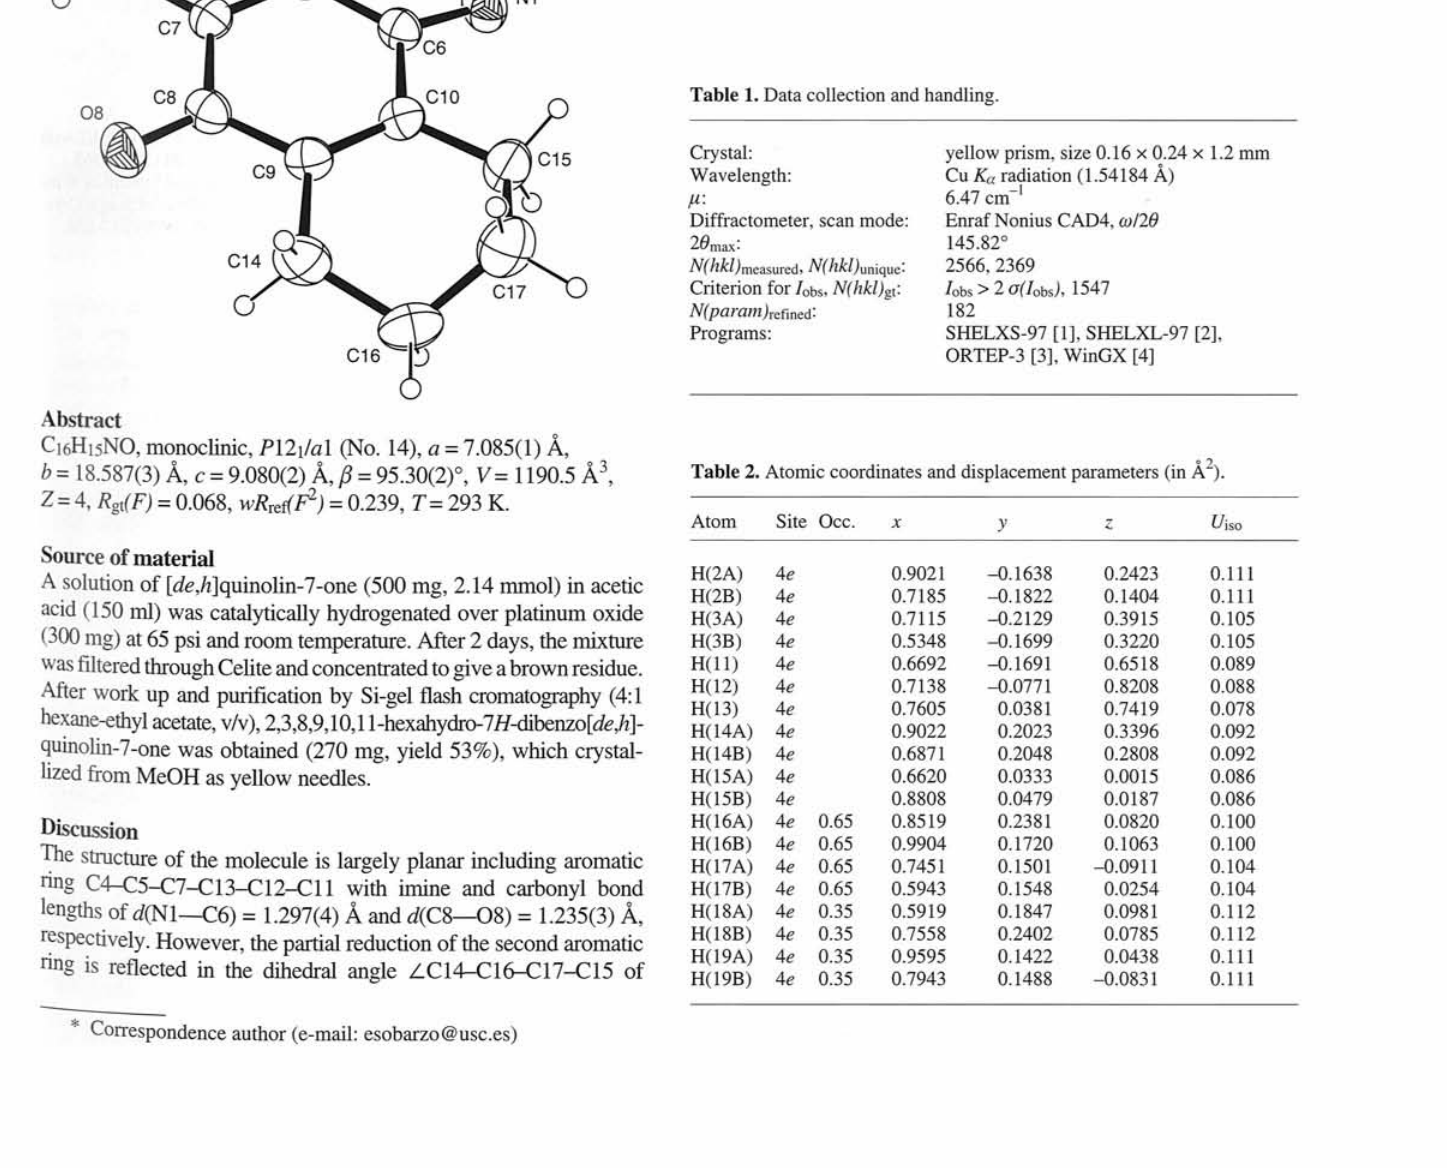
Table 1. Data collection and handling.